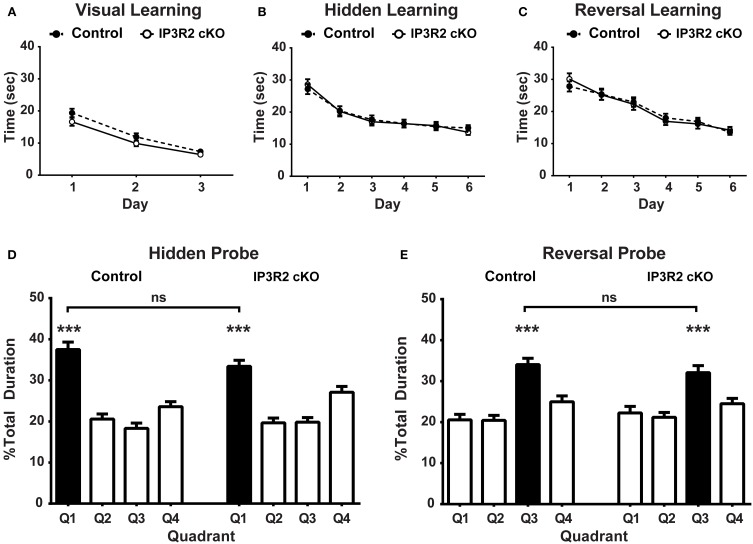
Morris water maze for learning and memory are unaffected in the IP3R2 cKO. (A) Training for the visually identified location of the escape platform was not significantly different (p = 0.08) between IP3R2 cKO mice (clear circles, n = 46) and control mice (solid circles, n = 53). (B) Hidden platform training over the course of 6 days showed that IP3R2 cKO mice displayed no significant difference in acquisition of the location of hidden platform compared to controls (p = 0.92). (C) Reversal of acquisition and acquisition of the relocated platform location training over the course of 6 days displays no significant difference between IP3R2 cKO and controls (p = 0.97). (D) Both IP3R2 cKO and control mice present a significant preference (IP3R2 cKO, p ≤ 0.0001; control p < 0.0001) for the target quadrant (Q1) in the probe trial of the hidden platform acquisition task. Direct comparison of Q1 preference is not significantly different (p = 0.57) between the two groups. (E) Both IP3R2 cKO (p < 0.0001) and control mice (p < 0.0001) display a significant preference for the target quadrant (Q3) in the probe trial of the reversal hidden platform task. Direct comparison of Q3 preference is also not significantly different (p = 0.99) between the two groups. Error bars indicate s.e.m. ***
p < 0.001.